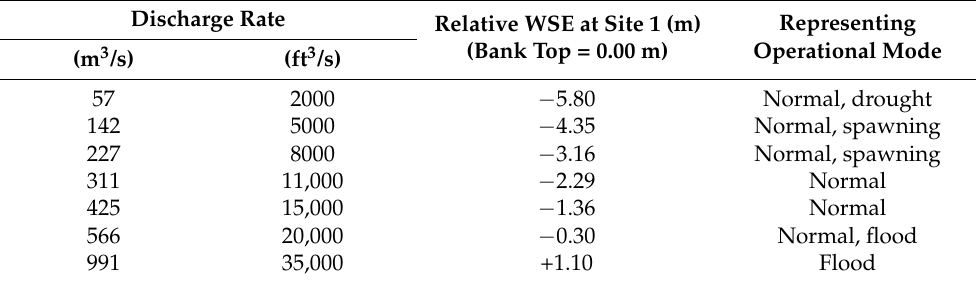
Table 4. Representative flow rates for modeling and expected corresponding water surface elevation at Site